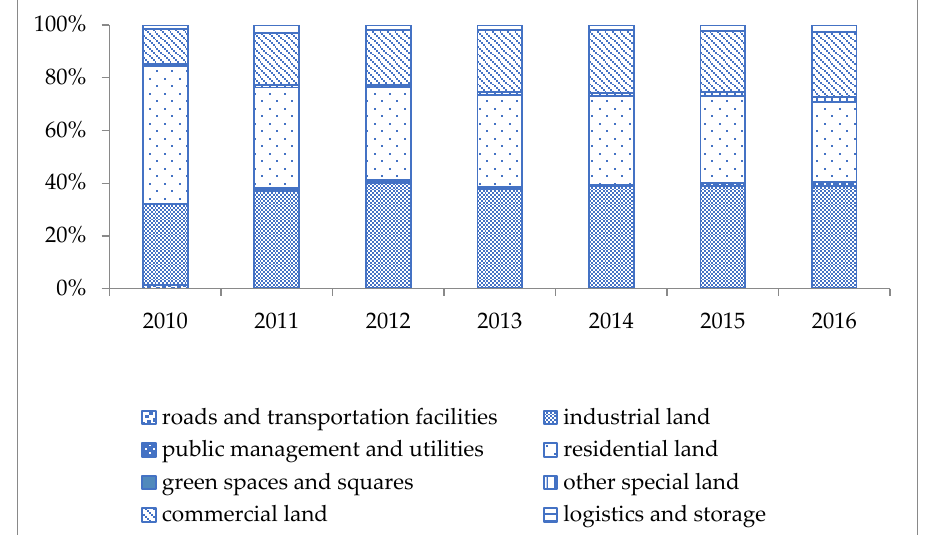
Figure 3. China’s land transfer structure from 2010 to 2016.